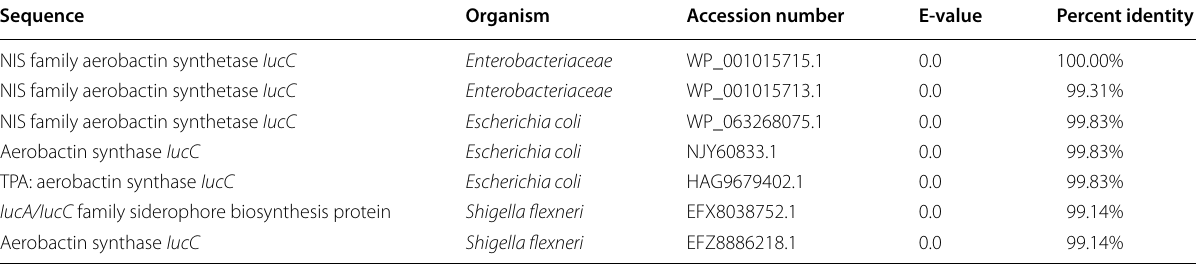
Table 4 The microorganisms showing similar sequences to the first siderophore biosynthetic gene in E. coli VR50